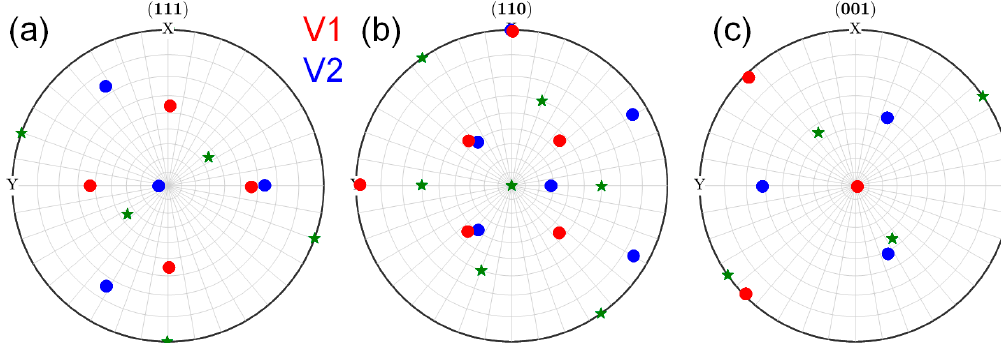
Figure 10. Two variants, V1 (red) and V2 (blue), of the α ’martensite transformed from an RB-oriented γ matrix (green) shown in ( a ) {111}, ( b ) {110}, and ( c ) {001} pole figures.